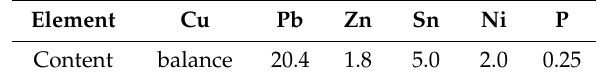
Table 2. Chemical compositions of the ZCuPb20Sn5 copper alloy (wt.%).